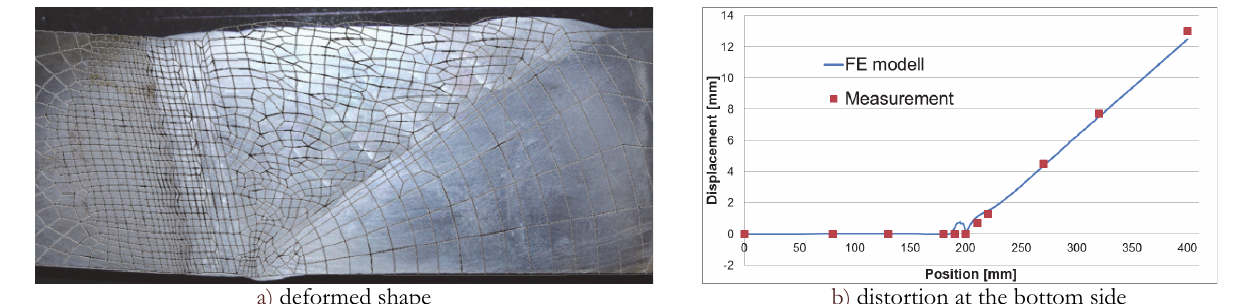
Figure 8: Distortion after